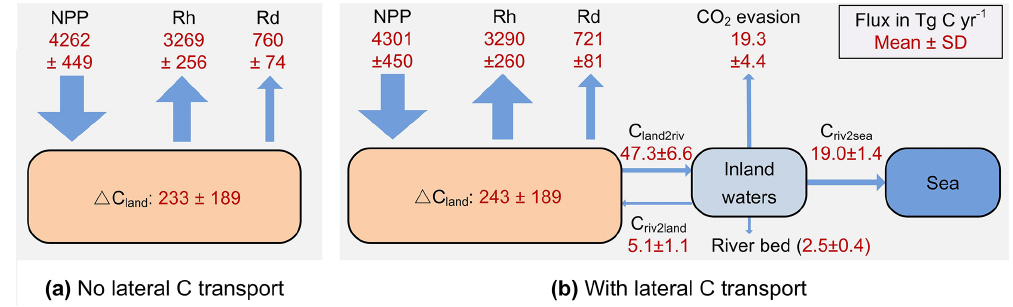
Figure 11. The simulated average annual carbon budget of the terrestrial ecosystem in Europe during the 1901–2014 when the lateral carbon transport is ignored (a) and considered (b) . All fluxes are presented as mean ± standard deviation. NPP is the net primary production. Rh and Rd are the heterotrophic respiration and the respiration due to disturbances like harvest and land cover change, respectively. (cid:49)C land represents the average annual changes in the total land carbon stock. The percentage following each of these changes in blue represents the average annual relative changes in the corresponding carbon pool. C land2riv , C riv2land , and C riv2sea are the average annual carbon fluxes